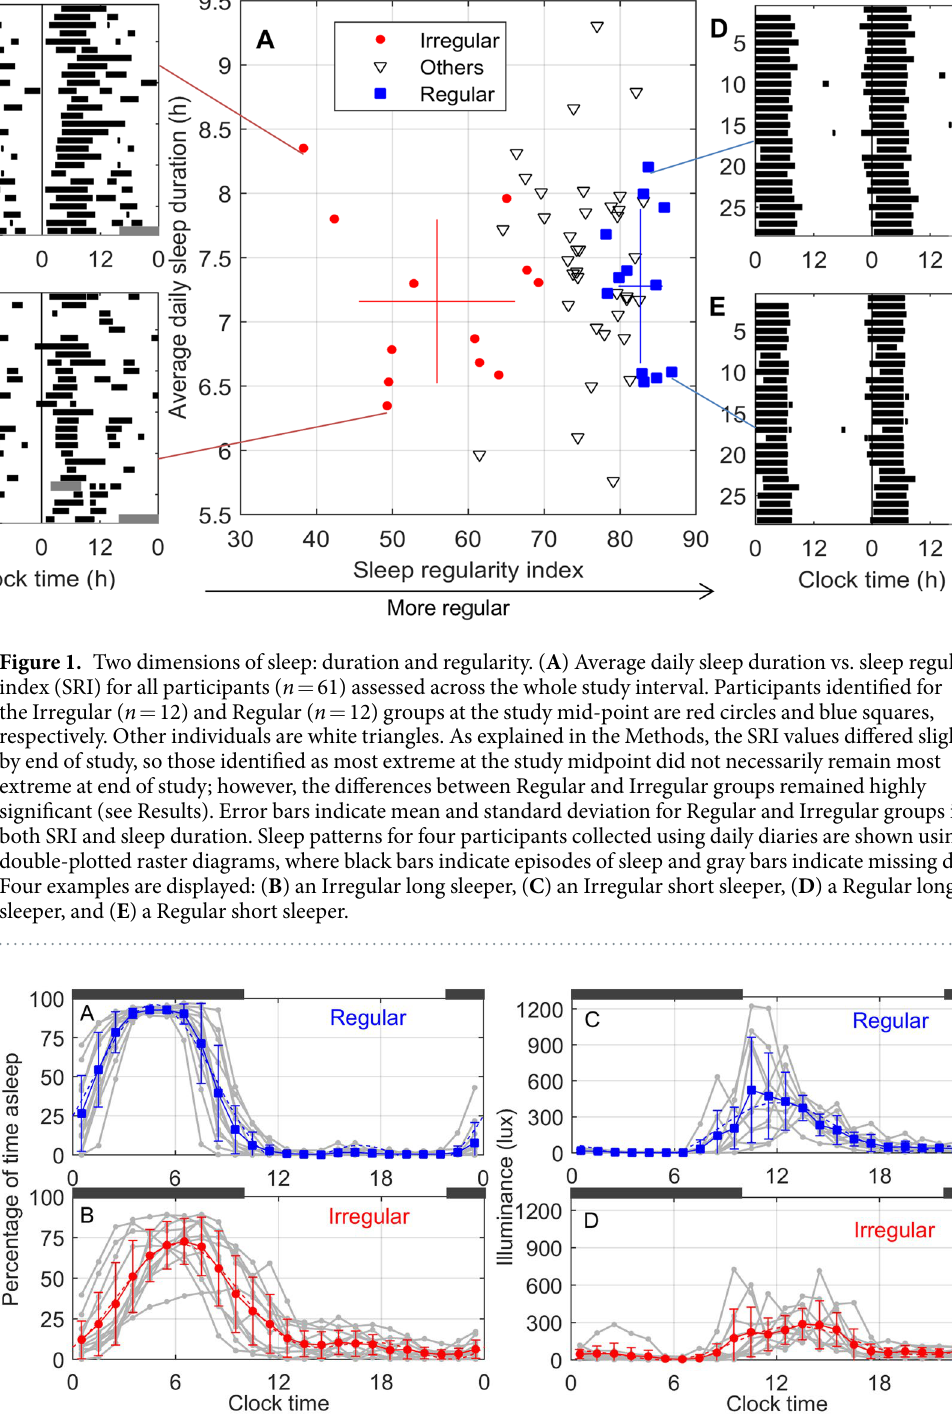
Sleep onset and morning awakening times differed significantly between groups. In Irregular sleepers, the average subjectively-reported time of sleep onset was 03:02 ± 1:23 vs. 01:15 ± 0:51 in Regular sleepers (p < 0.001,